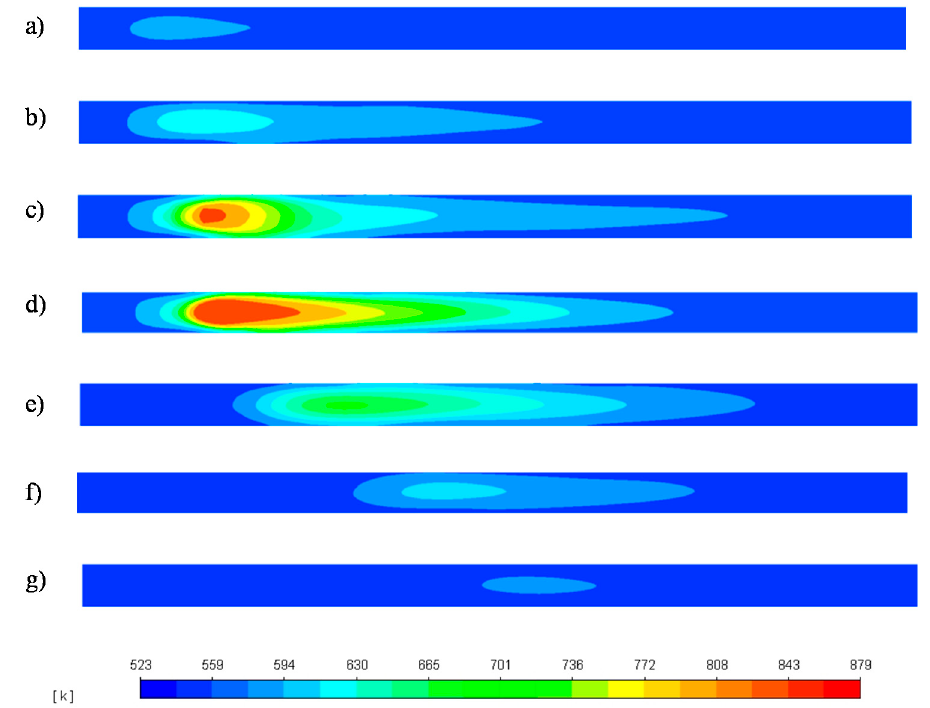
Figure 5. Temperature contours in the hot-spot relevant zone (First 500 mm of reactor tube length) for: Start-up operation: ( a ) 10 s, ( b ) 20 s, ( c ) 40 s, ( d ) 330 s and Shut-down operation: ( e ) 365 s, ( f ) 405 s, ( g ) 460 s.